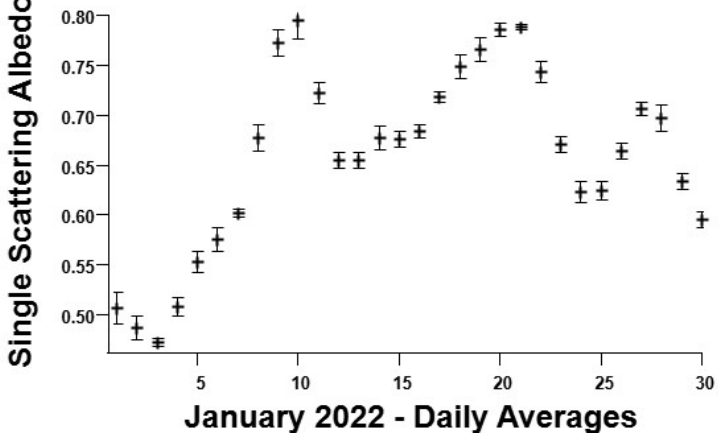
Figure 4. Daily averages of the single scattering albedo were calculated for January 2022 from the absorption and scattering coefficients due to EBC detected by the PAX 870 nm. The graph has a smoothing filter applied (binomial smoothing by Wave Metrics Igor Pro 8 platform). Each point represents a daily average, and the errors are the standard error associated with each point.